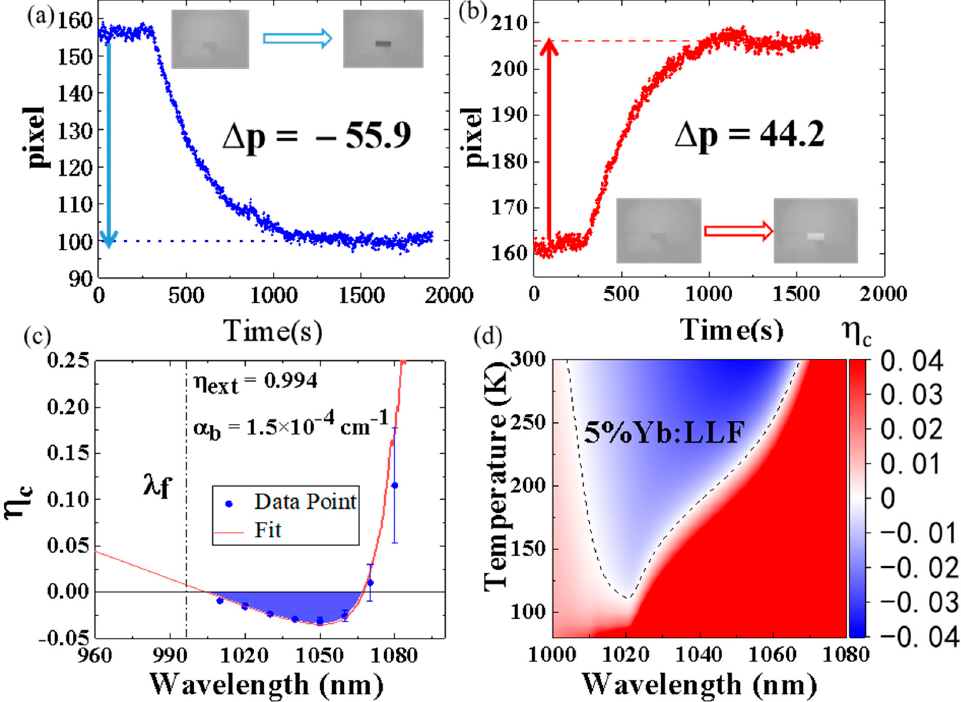
Figure 4. The LITMoS test of the 5% Yb 3+ :LuLiF 4 crystal. ( a ) The pixel intensity changes of the thermal camera at 1015 nm pumping. The inset is the thermal image of the sample. ( b ) The pixel intensity changes of the thermal camera at 1080 nm pumping. The inset is the thermal image of the sample. ( c ) The measured η c ( λ ) exp as shown by blue dots and model fitting of Equation (1) with the parameters of η ext = 99.4 ( ± 0.1 ) % and α b = 1.5 ( ± 0.1 ) × 10 − 4 cm − 1 as shown by the red solid curve. ( d ) The cooling window of 5% Yb 3+ :LuLiF 4 crystal. The blue region and the red region correspond to cooling and heating, respectively.